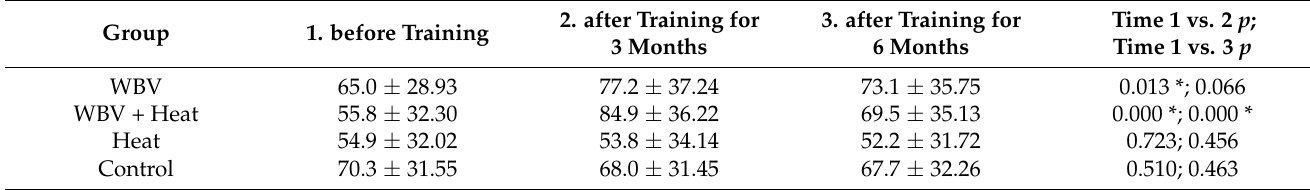
Table 3. Comparison of the Training Effect on Muscle Strength in Six Months.